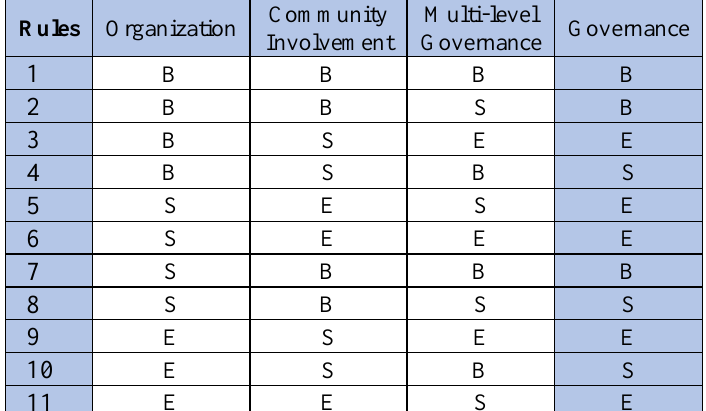
Table 5 . Lookup table for proposed